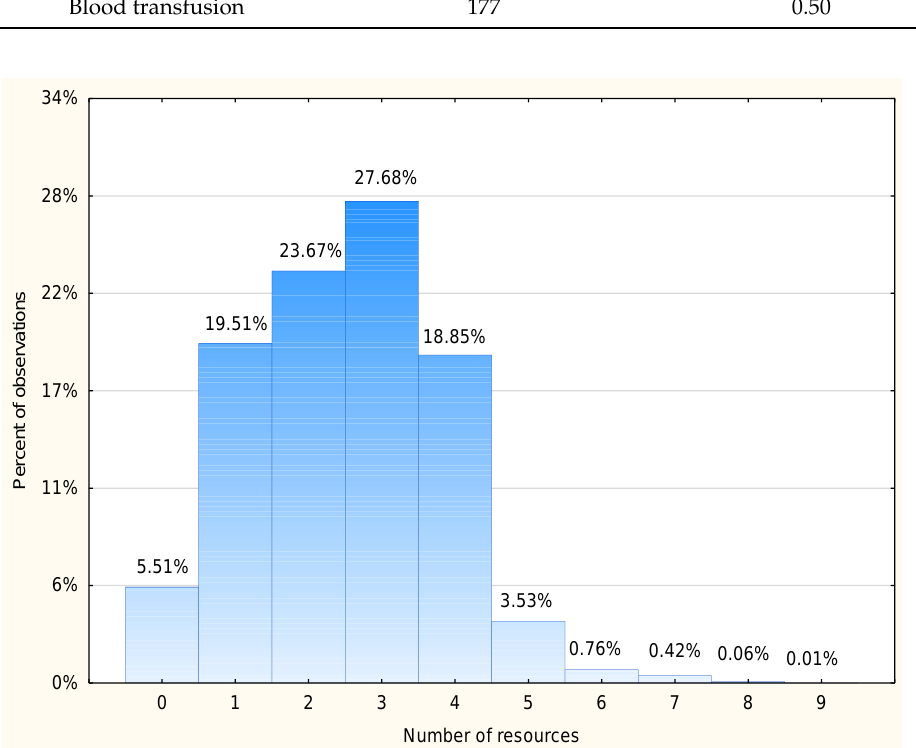
Figure 2. Percent of patients who required respective number of resources. Resources were defined as any laboratory tests, radiological scans, medications administered, urinary catheter, oxygen supplementation, suturing, cast immobilization, catecholamines infusion, rapid sequence induction and blood transfusion.